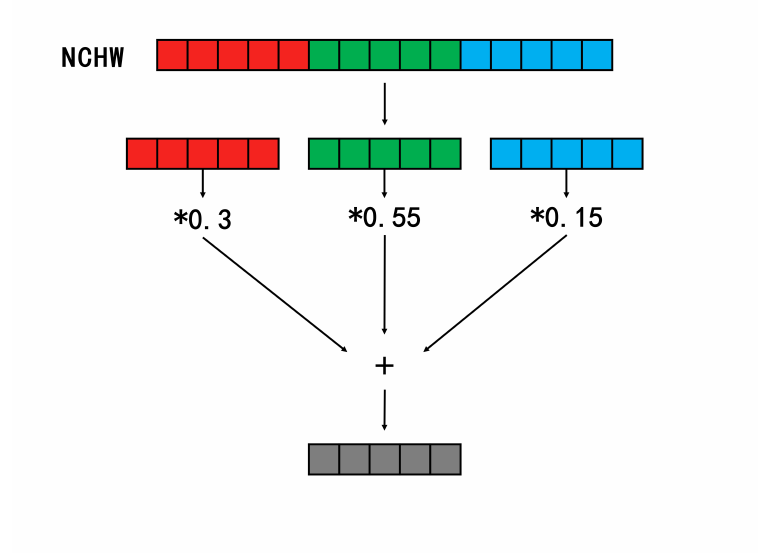
Figure 7. Calculation of grayscale in NCHW format.